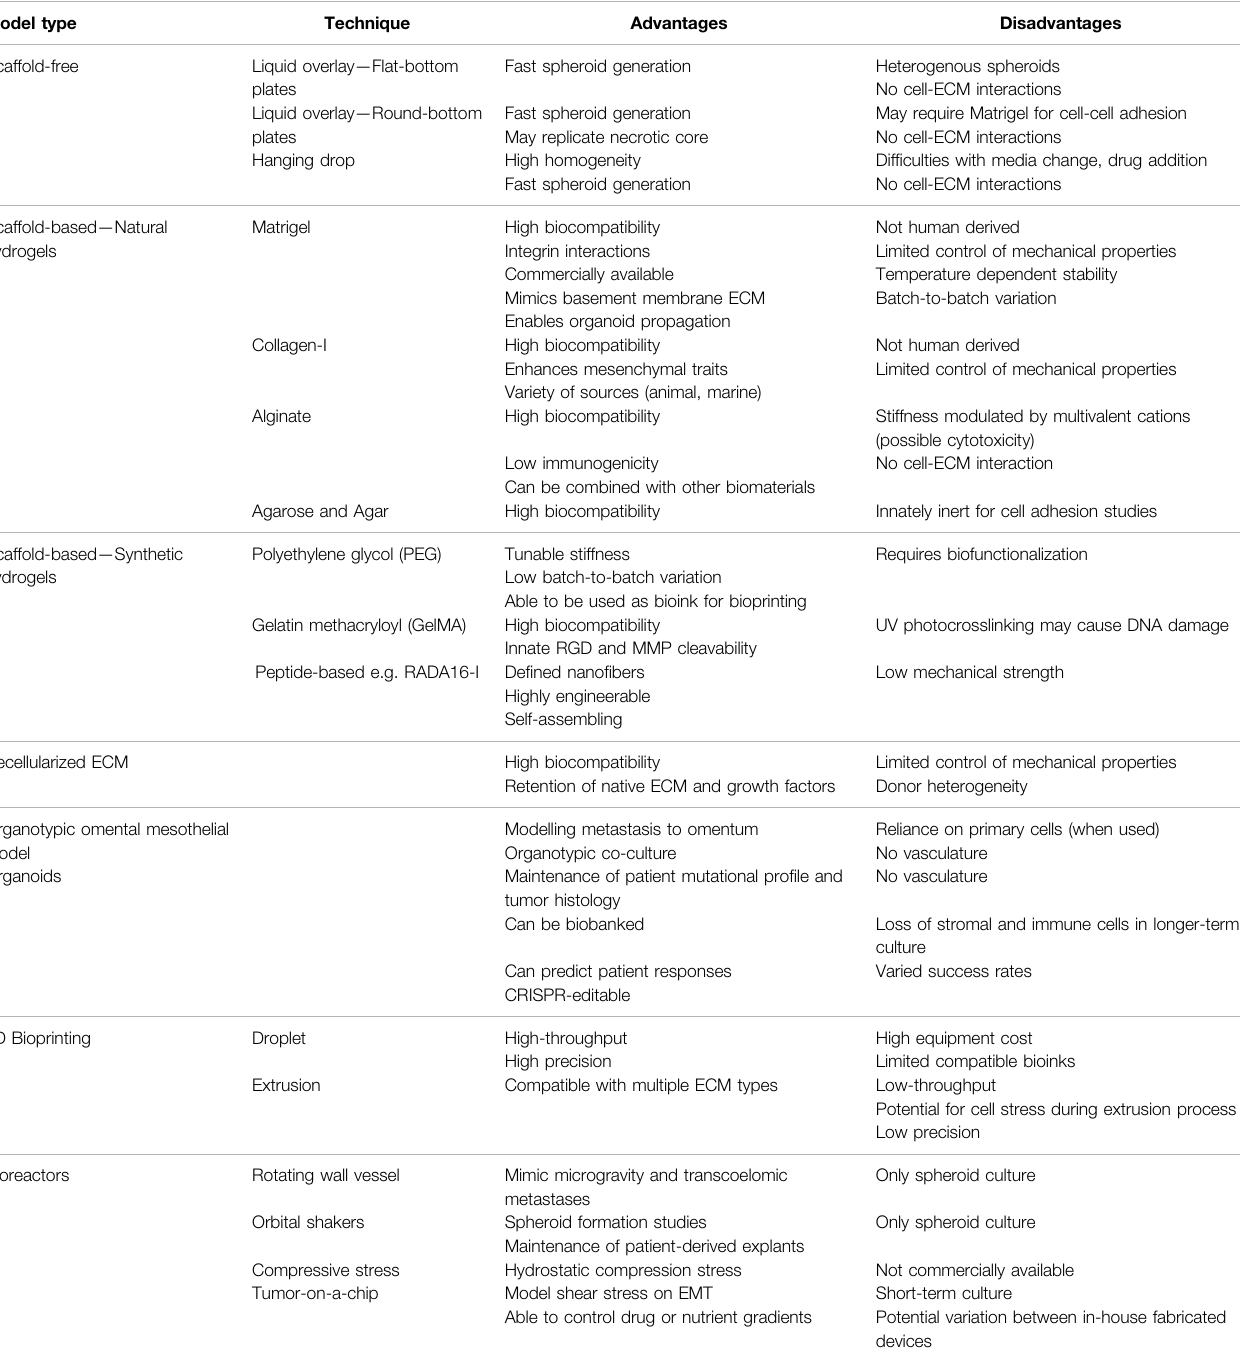
TABLE 2 | Advantages and disadvantages of common 3D in vitro models of ovarian